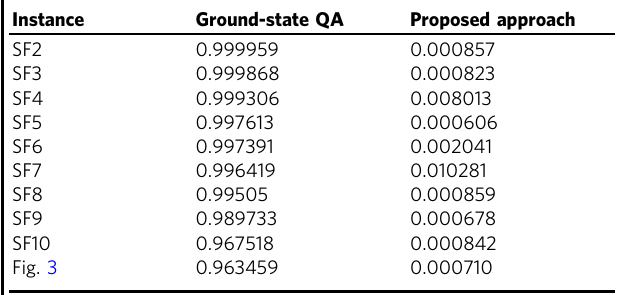
Fig. 4 Cumulative distribution of minimum energy gaps during ground- state quantum annealing (QA) with a network of Kerr-nonlinear parametric oscillators (KPOs). Values are shown for the same 1000 instances as those in Fig. 1. The minimum energy gaps are normalized by their average value. The vertical axis plots the number of instances whose minimum energy gaps are smaller than the value of the horizontal